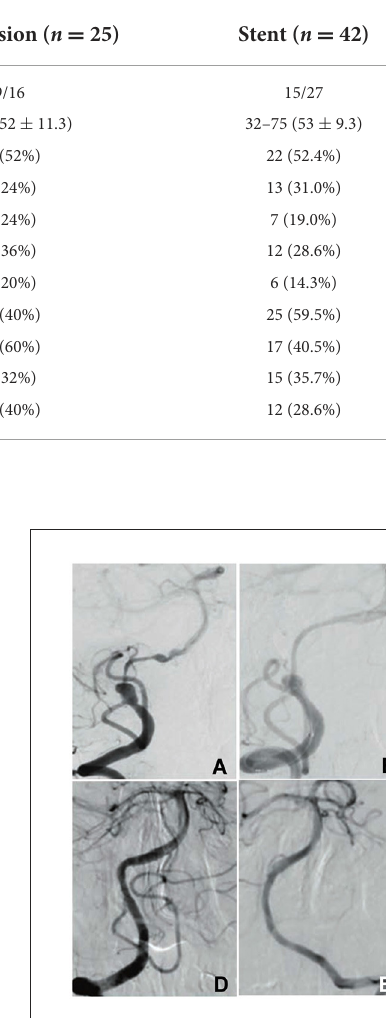
FIGURE1 A patient with intermittent headache was hospitalized. (A) Cerebral angiography revealed a dissecting aneurysm at the intracranial vertebral artery concomitant with distal long-segment stenosis. (B,C) A flow diverter was deployed to cover the aneurysm. (D) Angiography 3 months later demonstrated complete occlusion of the dissecting aneurysm with the stenosis being relieved and patent posterior inferior cerebellar artery. (E) The left vertebral artery was normal. (F) Three-dimensional angiography of reconstruction showed complete occlusion of the dissecting aneurysm and patent flow